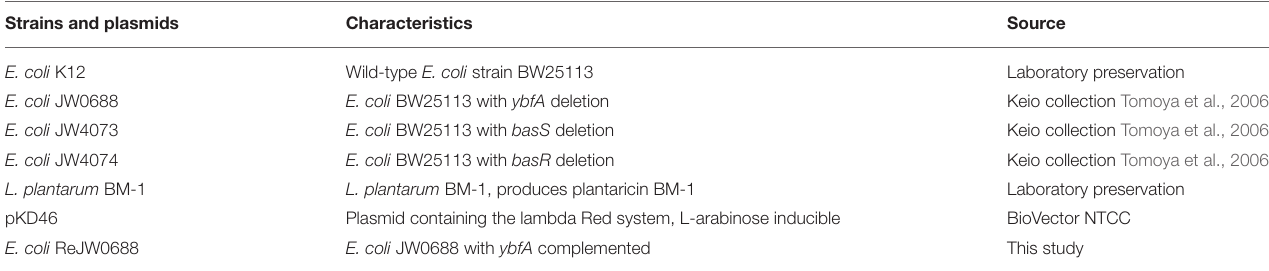
TABLE 2 | Strains and plasmids used in this